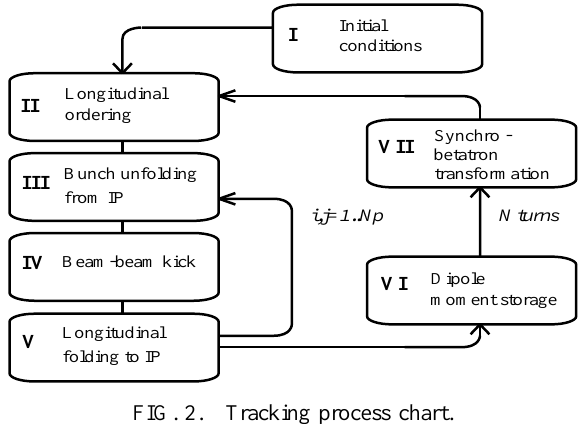
FIG. 2. Tracking process